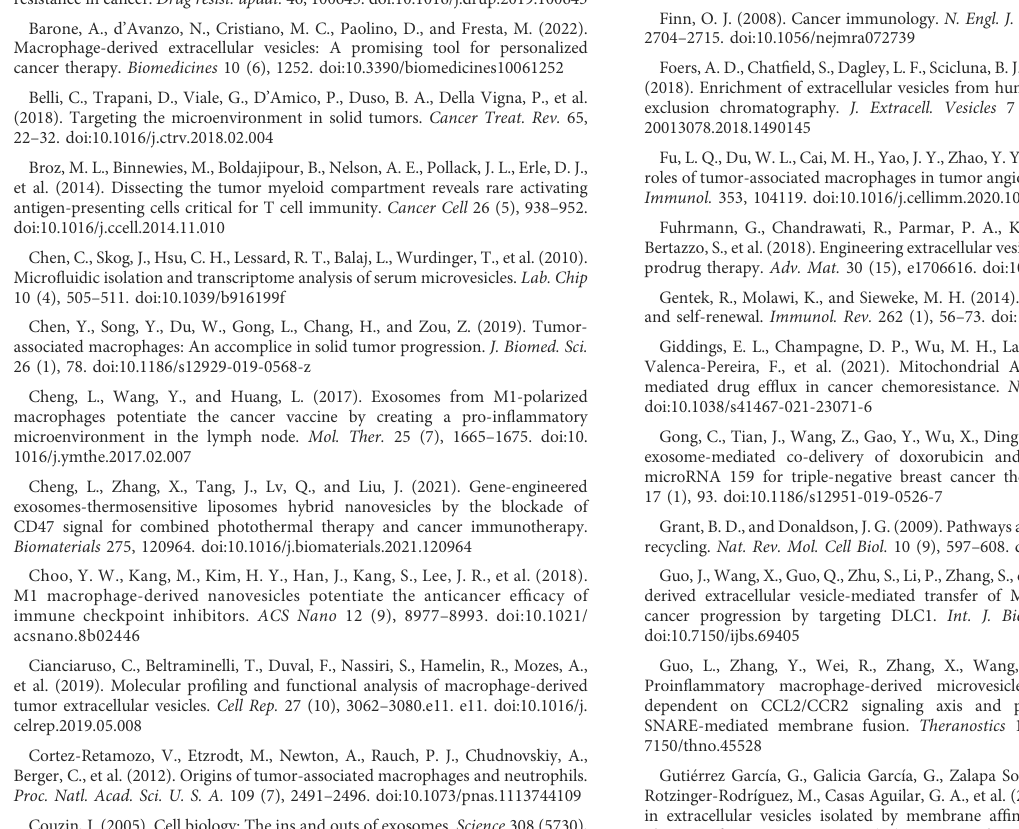
Figueiredo, P., Lepland, A., Scodeller, P., Fontana, F., Torrieri, G., Tiboni, M., et al. (2021). Peptide-guided resiquimod-loaded lignin nanoparticles